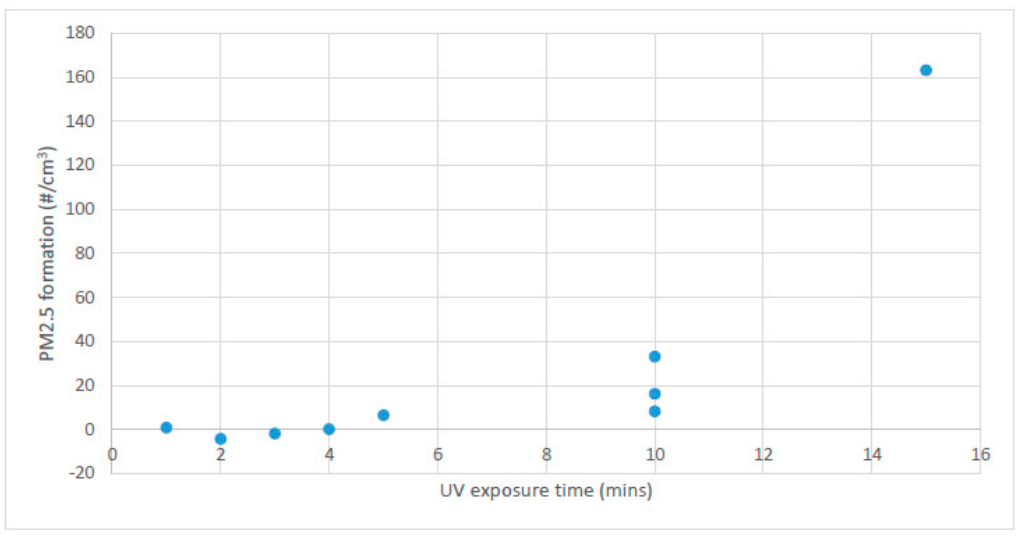
Figure 2. Fine particulate matter (PM2.5) formation (corrected for initial background counts) as a function of UV exposure time, with a constant recirculation time of 5 min after UV exposure, for initial toluene concentrations in air of 55 to 85 mg/m 3 . Triplicate experimental results are shown for 10 min.